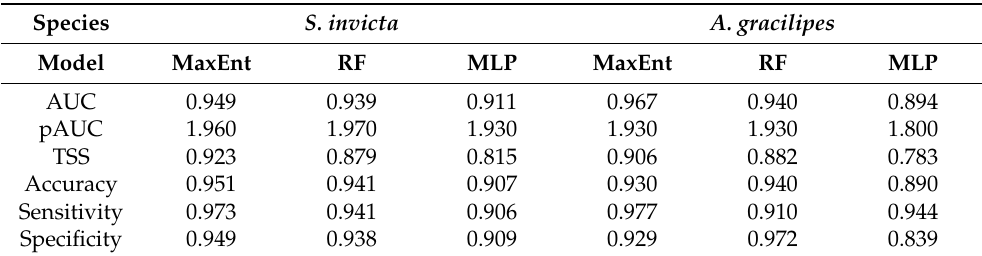
Table 2. Model performance metrics for both ant